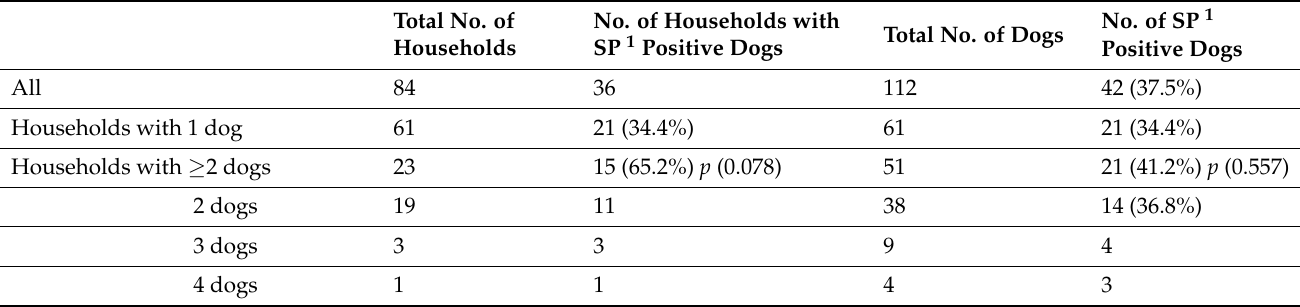
Table 4. Number of dogs in households carrying S. pseudintermedius .